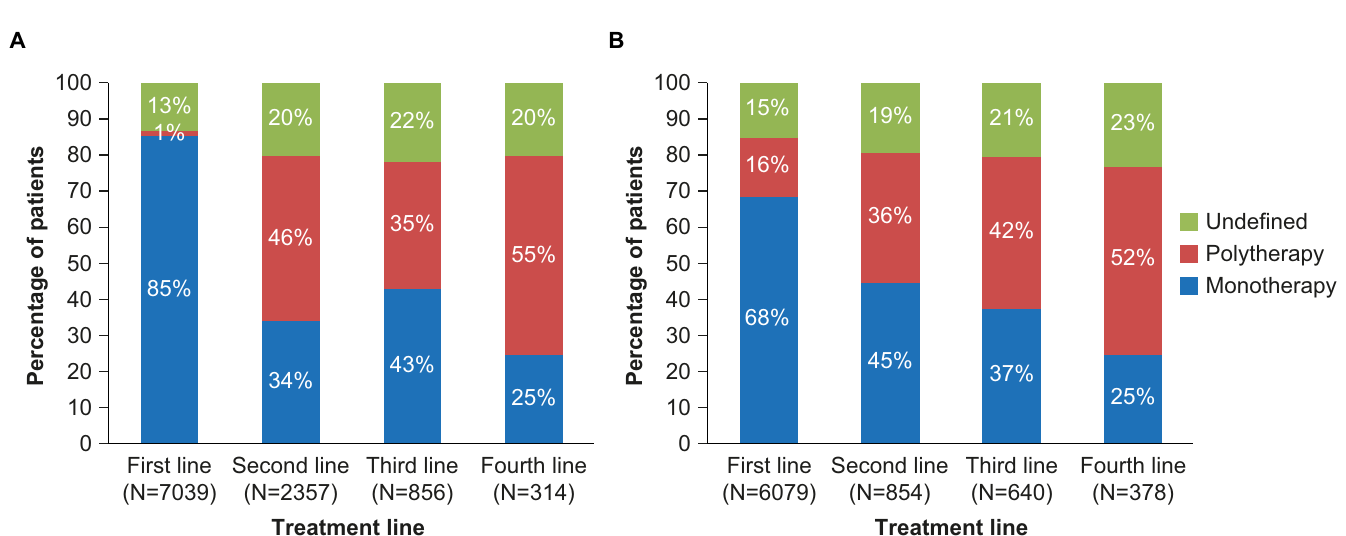
Fig 1. PD medication treatment lines for (A) patients with PD in the US who received one or more treatment lines, and (B) patients with PD in the UK who received one or more treatment lines.